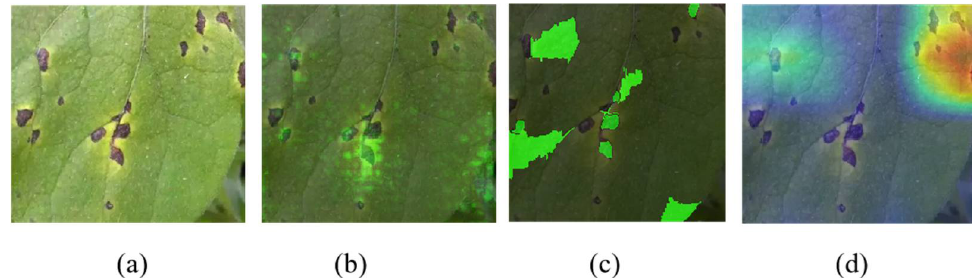
Figure 9. Schematic diagram of three visualization methods. ( a ) Original image. ( b ) Visualized schematic diagram of the SmoothGrad method. ( c ) Visualized schematic diagram of the LIME method. ( d ) Visualized schematic diagram of the GradCAM method.